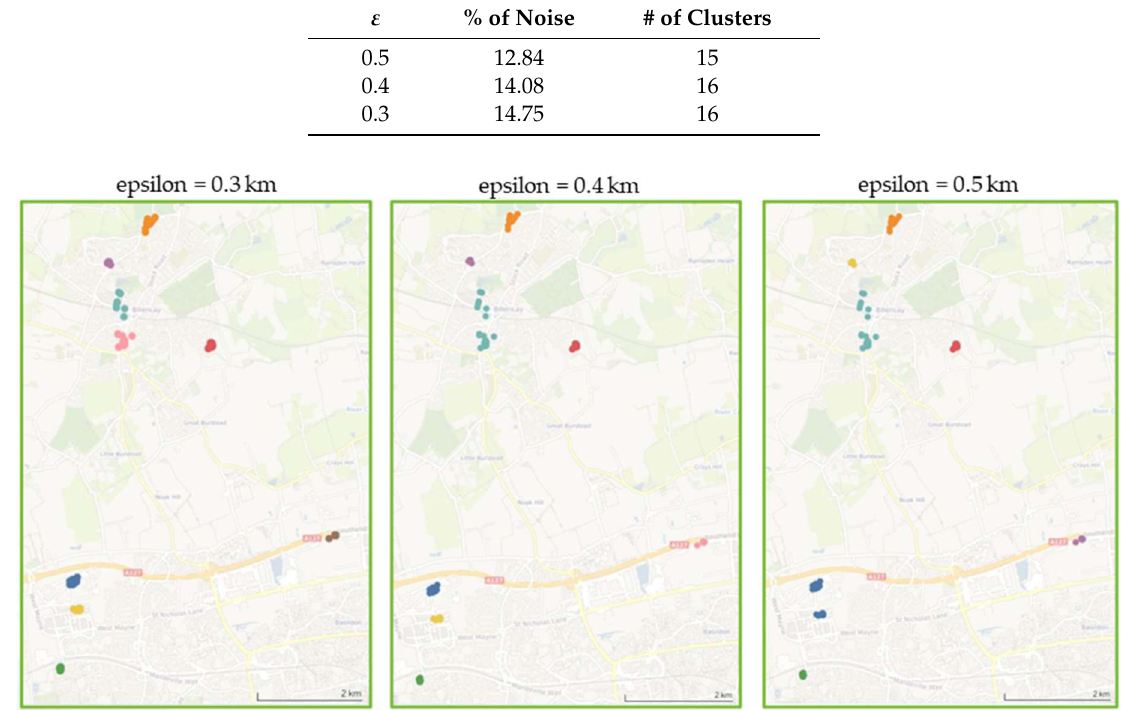
Figure 8. Clustering results.